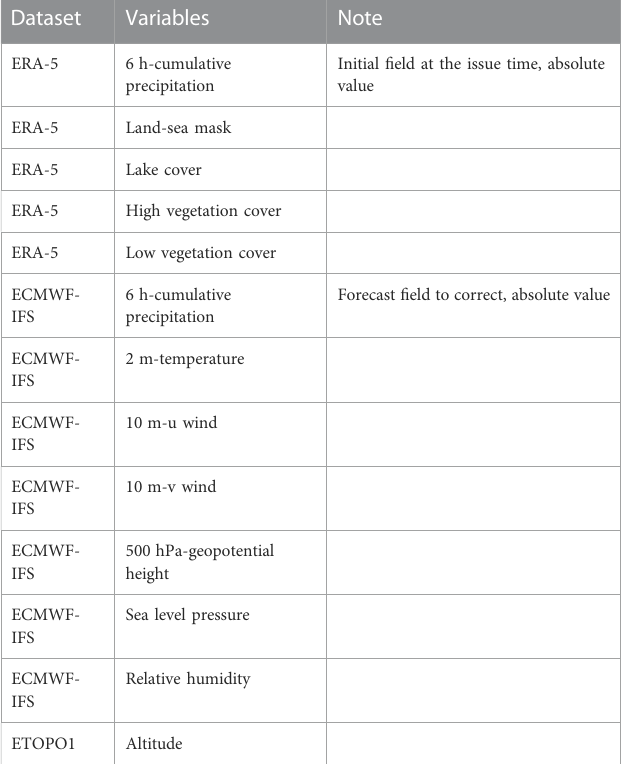
TABLE 1 The input variables of the correction model.